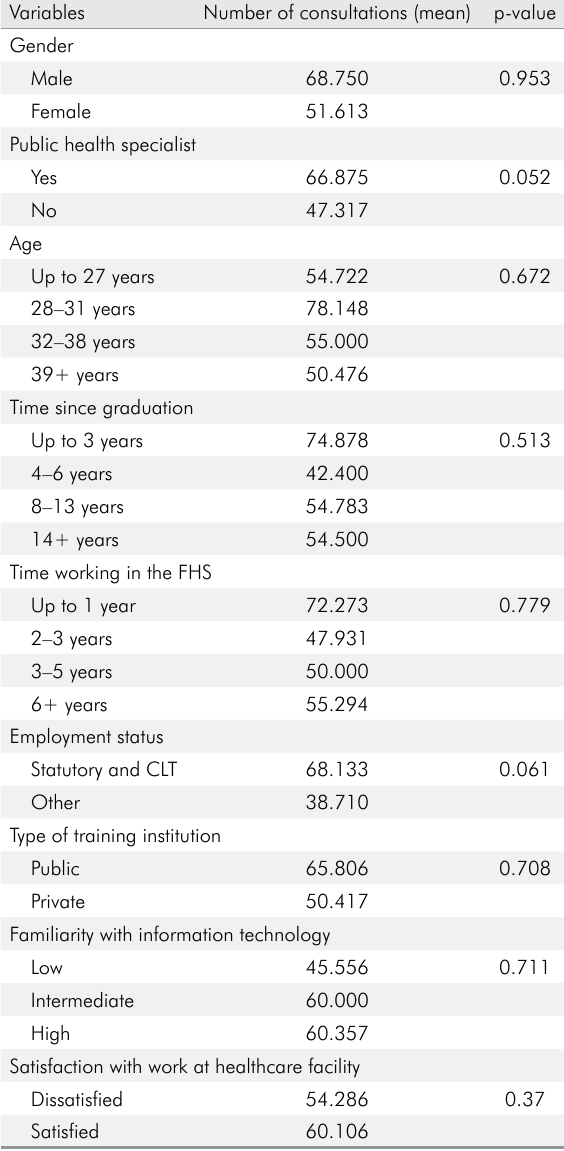
Table 3. Associations between the number of consultations performed only by dentists and the variables presented in Table 1.